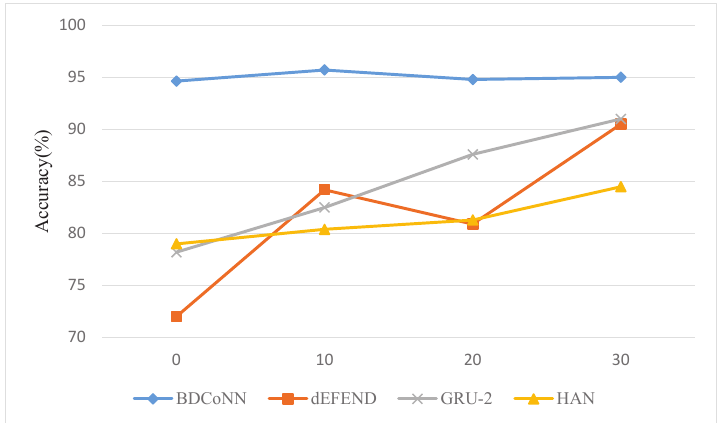
Figure 5. Accuracy of early rumor detection on the Weibo